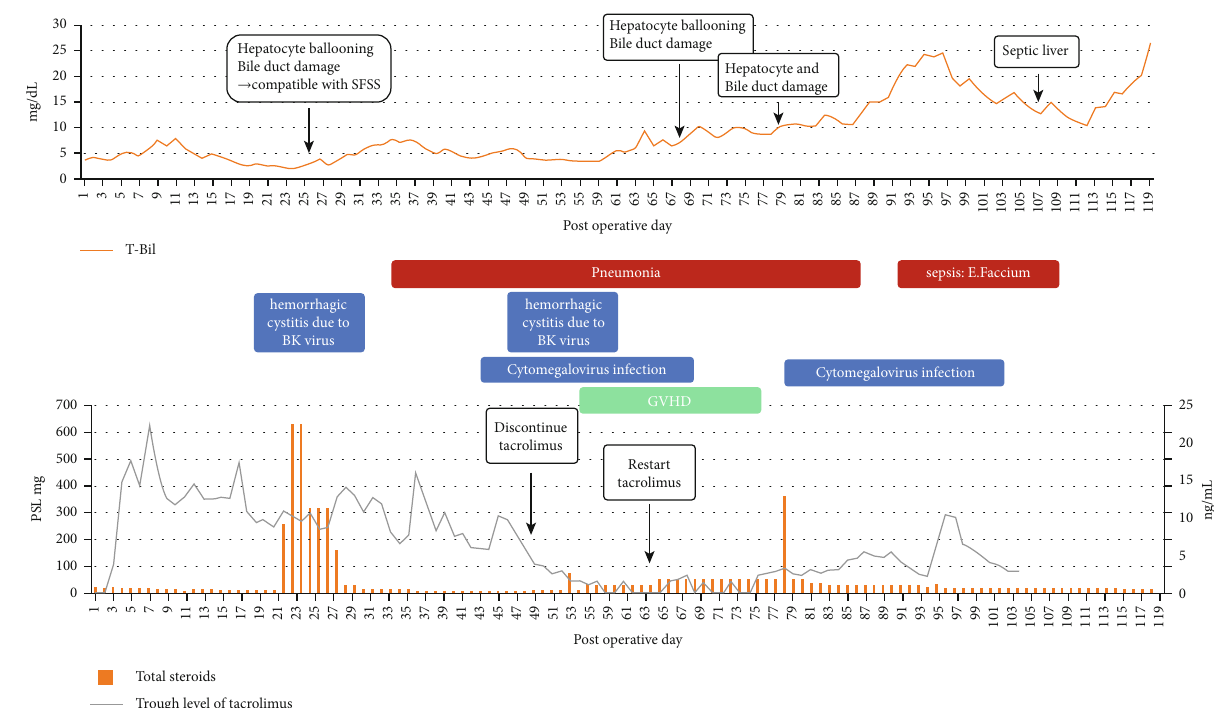
Figure 2: Postoperative course in this patient. The upper graph shows total bilirubin, aspartate aminotransferase, and alanine aminotransferase level after LDLT, as well as liver biopsy fi ndings. The lower band shows the duration of granulocyte-stimulating factor administration and infectious